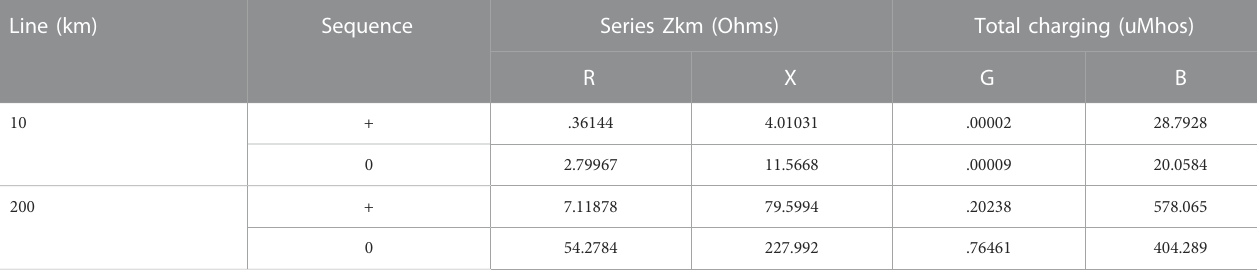
TABLE 2 Tested transmission line